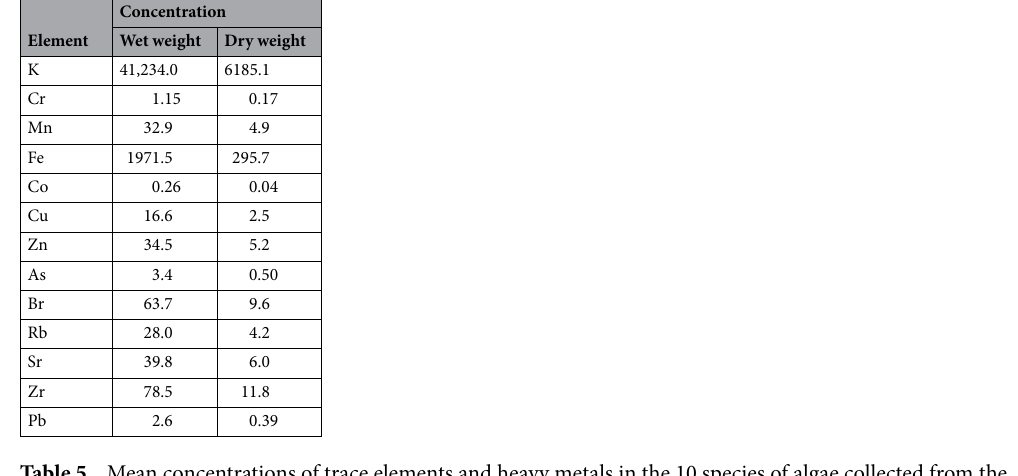
Table 5. Mean concentrations of trace elements and heavy metals in the 10 species of algae collected from the coastal waters of the Cox’s Bazar